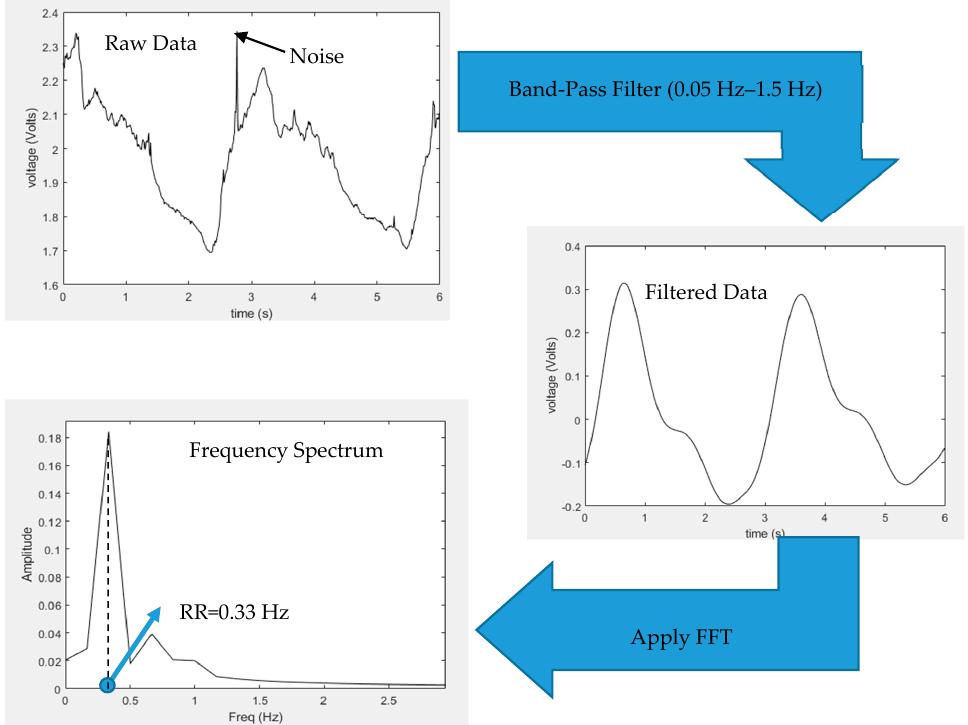
Figure 4. RR derivation flow chart from the IJP sensor. The raw data was input into band-pass